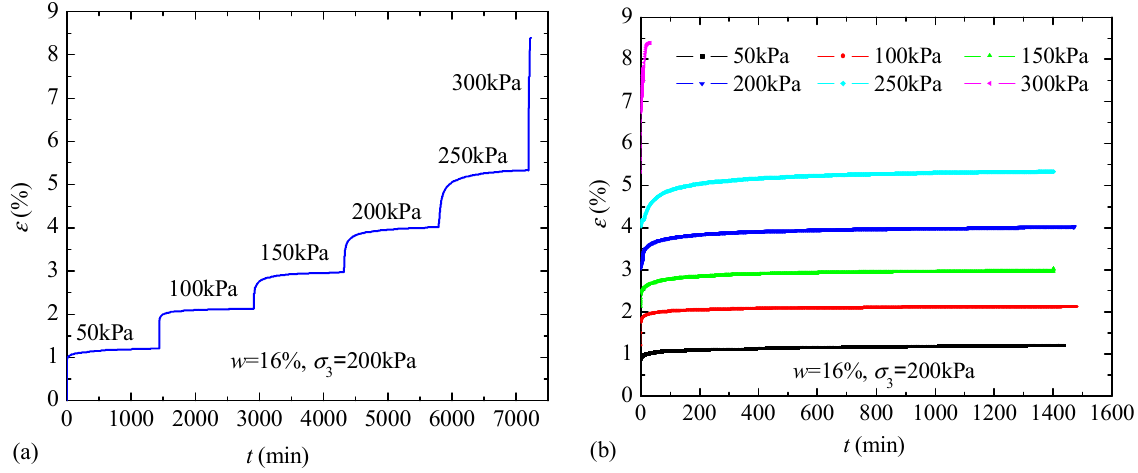
Figure 6. ( a ) The whole process curve of creep for loess with 5 dry-wet cycles, ( b ) creep curves of loess with 5 dry-wet cycles.